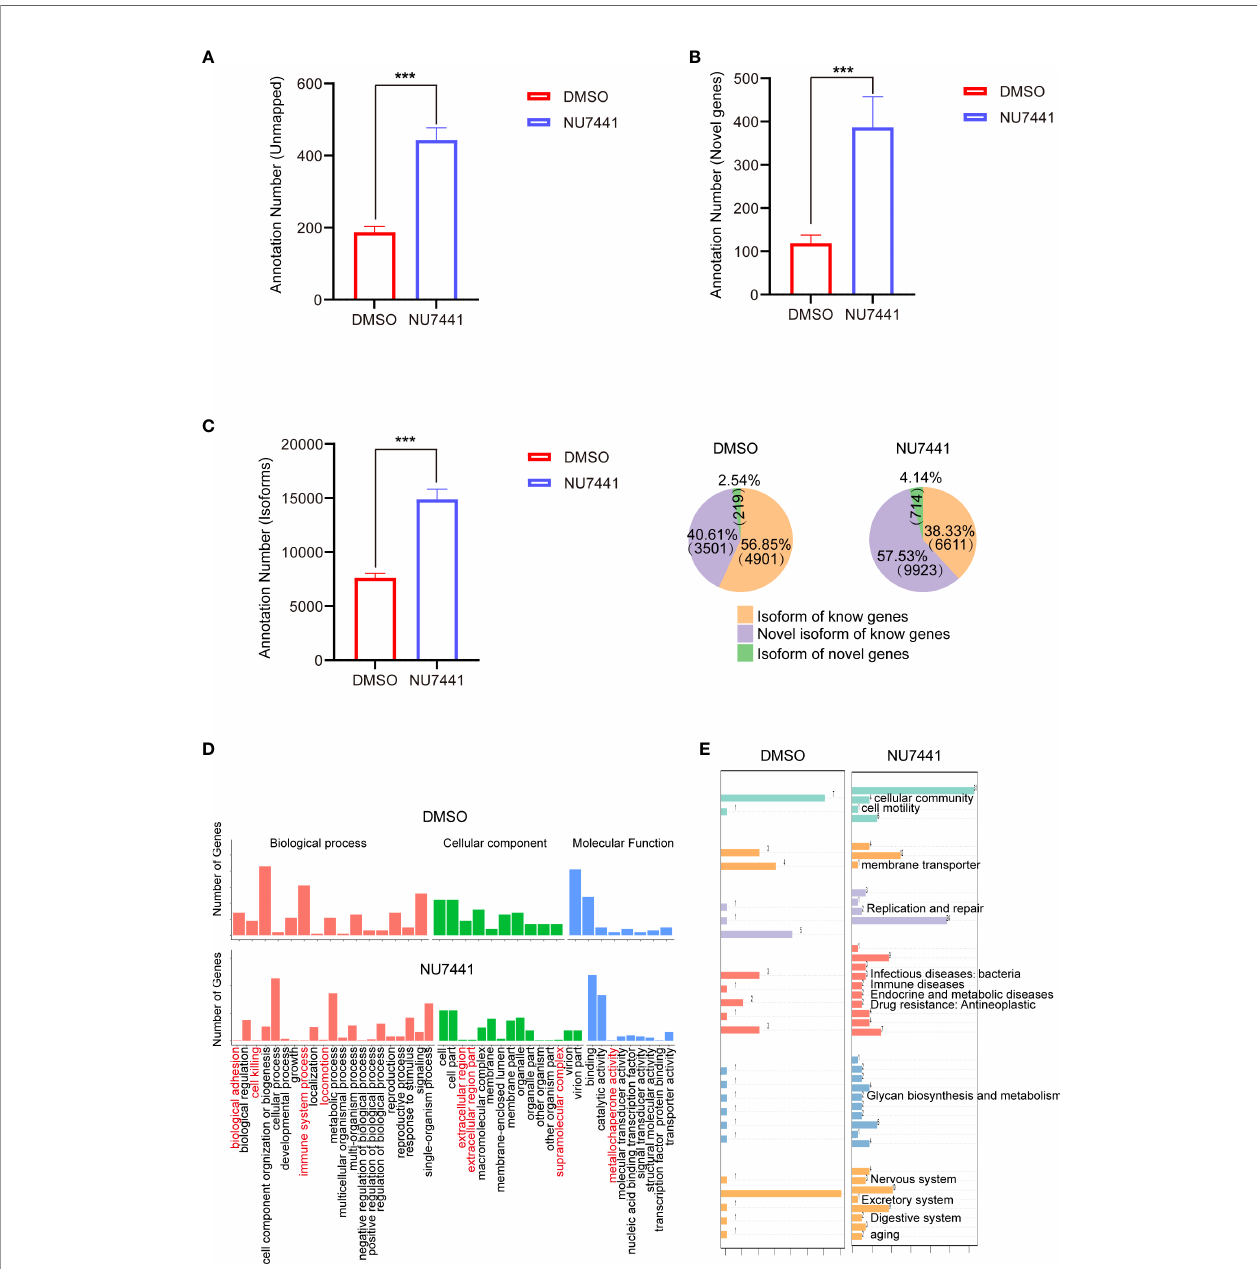
FIGURE 2 | Annotations of the long-read sequencing data. (A) Annotations of the unmapped transcripts in control cells and NU7441-treated cells ( p < 0.001). (B) Annotations of the novel genes in control cells and NU7441-treated cells ( p < 0.001). (C) Annotations of the isoforms in control cells and NU7441-treated cells in ( p < 0.001). (D) GO analysis of novel genes identi fi ed in control cells and NU7441-treated cells. (E) KEGG analysis of novel genes identi fi ed in control cells and NU7441-treated